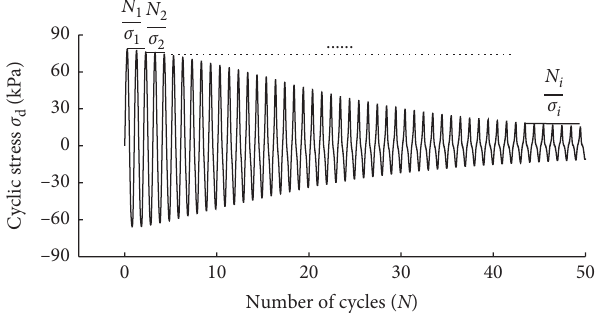
CSR = 0.444 × N (–0.140) R 2 = 0.976